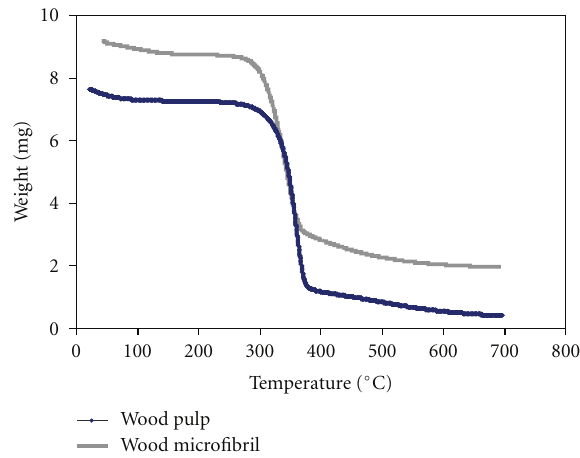
Figure 5: TGA thermograms of wood fibres before and after defi- brillation.